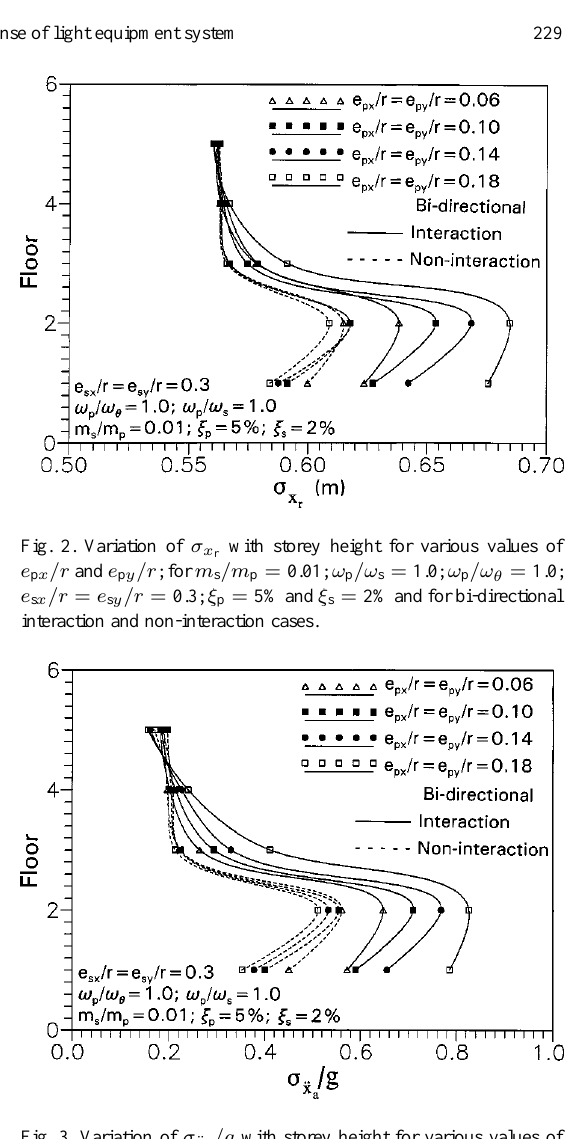
=g with storey height for various values of Fig. 3. Variation of (cid:27) (cid:127) x a e p x =r and e p y =r ; for m s =m p = 0.01; ! p =! s = 1.0; ! p =! (cid:18) = 1.0; e s x =r = e s y =r = 0.3; (cid:24) p = 5% and (cid:24) s = 2% and for bi-directional interaction and non-interaction